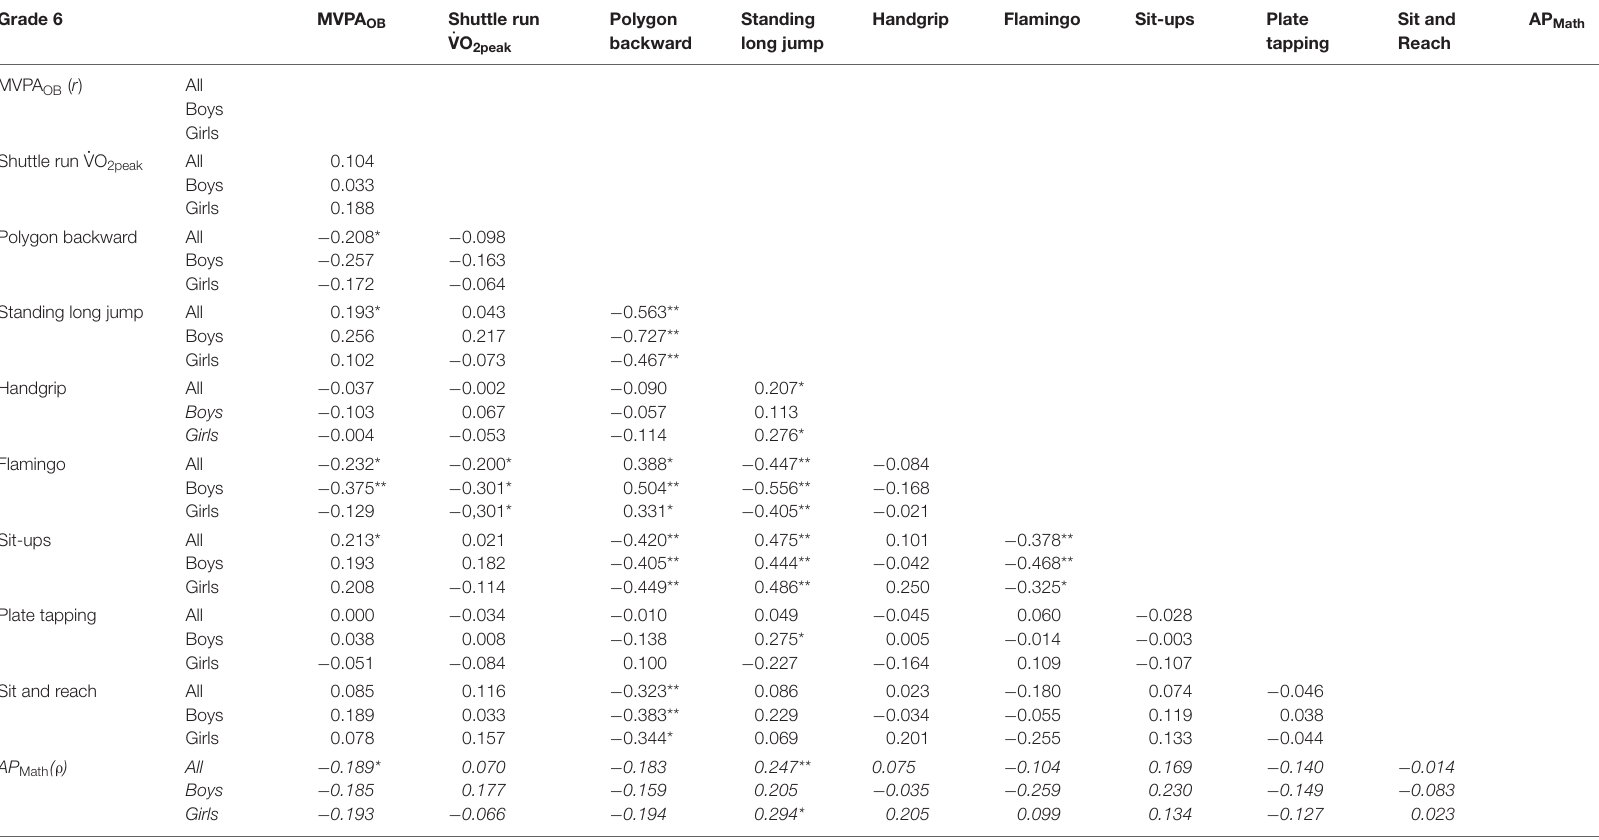
Aerobic power calculated from 20 m shuttle run ( ˙ VO 2peak ) following the Leger protocol (Leger and Lambert, 1982) and expressed in mL · kg − 1 min − 1 ; MVPA OB , physical activity measured directly using SenseWear Armbands in N = 50 sub-sample (N = 21 boys and 29 girls); AP math , academic performance (math grade, corresponding to the final grade awarded at the end of Grade 5); *Significant correlation p < 0.05; **Significant correlation p < 0.01; Italics font represents non-parametric correlations (Spearman